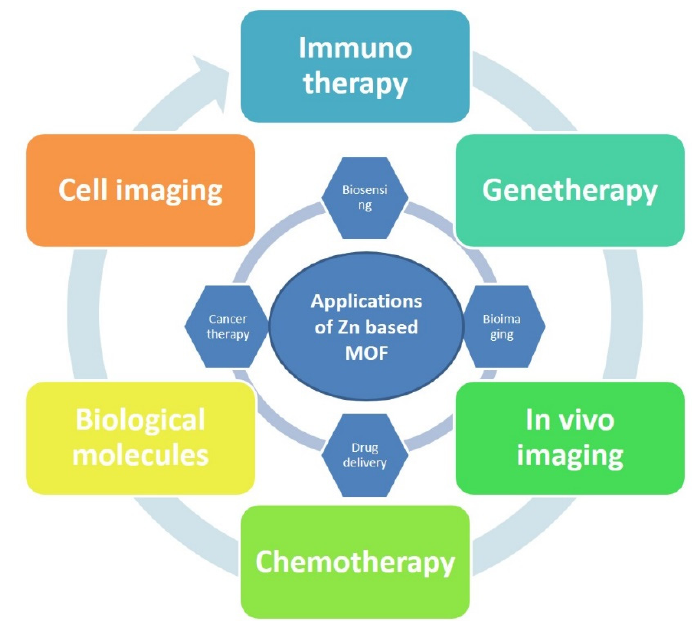
Figure 1. Summary of Zn-based MOFs applications.